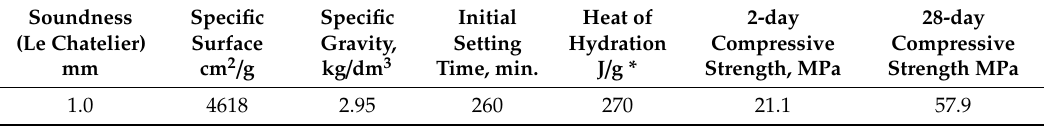
Table 4. Physical properties of CEM II / B-S 42.5 N cement.